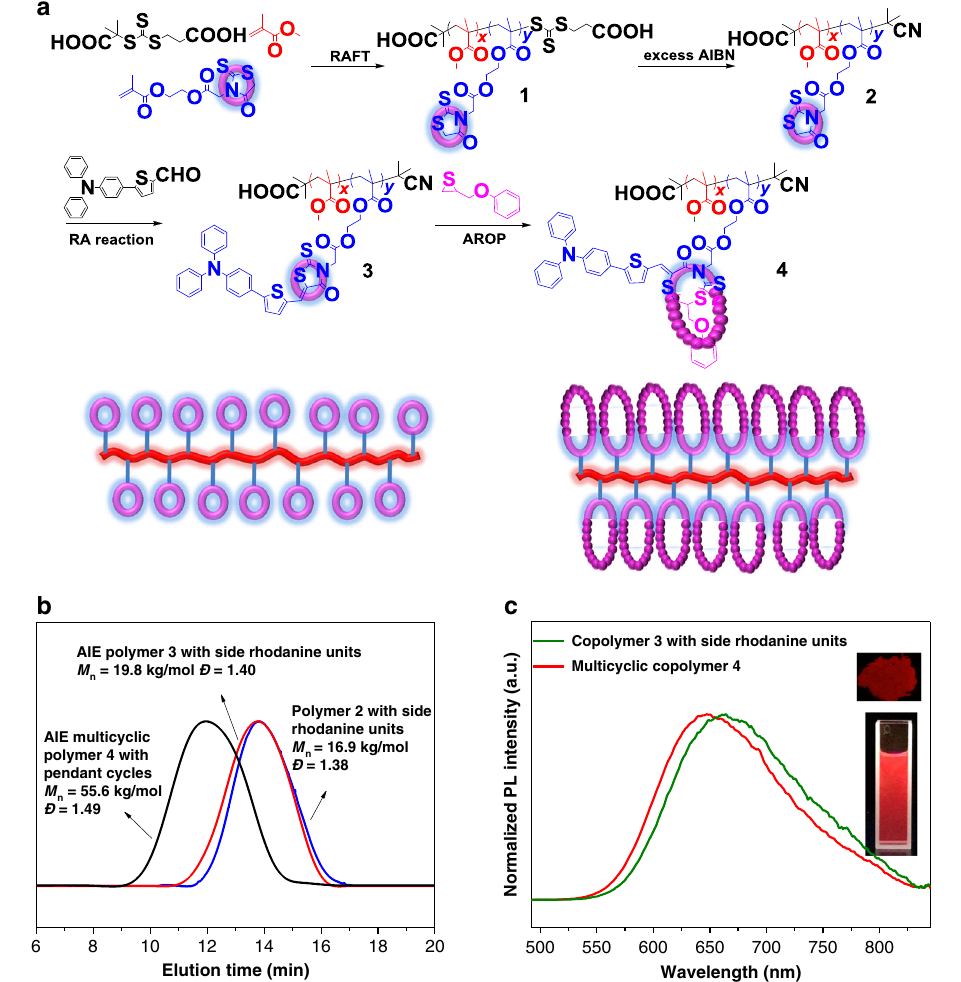
Fig. 8 Synthesizing AIE multicyclic copolymer with pendant cyclic structures. a Illustration of the synthetic route. b SEC curves for resulting polymers. c The normalized PL intensity of resulting red/near ˗ infrared AIE copolymer 3 and multicyclic copolymer 4. Inset: fl uorescent photographs of multicyclic copolymer 4 in solid state and in solution (H 2 O:THF =